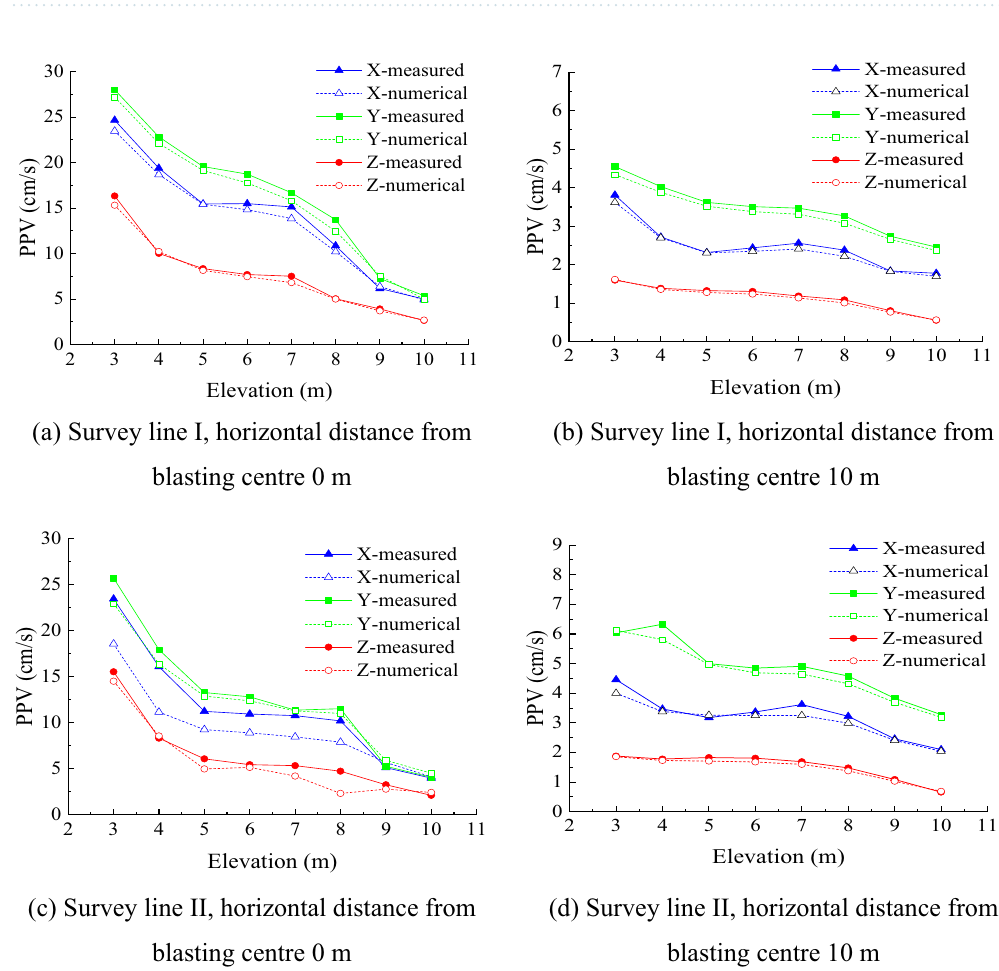
Figure 8. Comparison diagram of measured and numerically calculated PPV